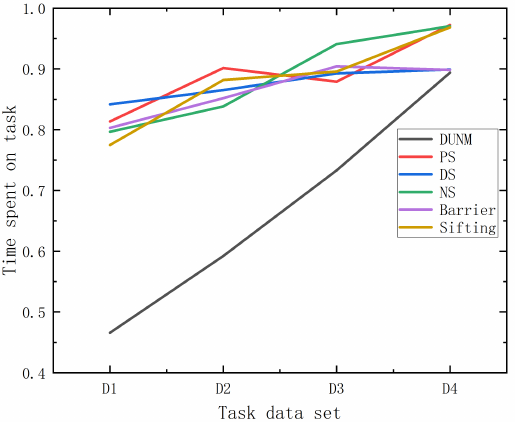
Figure 9. Comparison of the algorithm’s running times for different data sets.